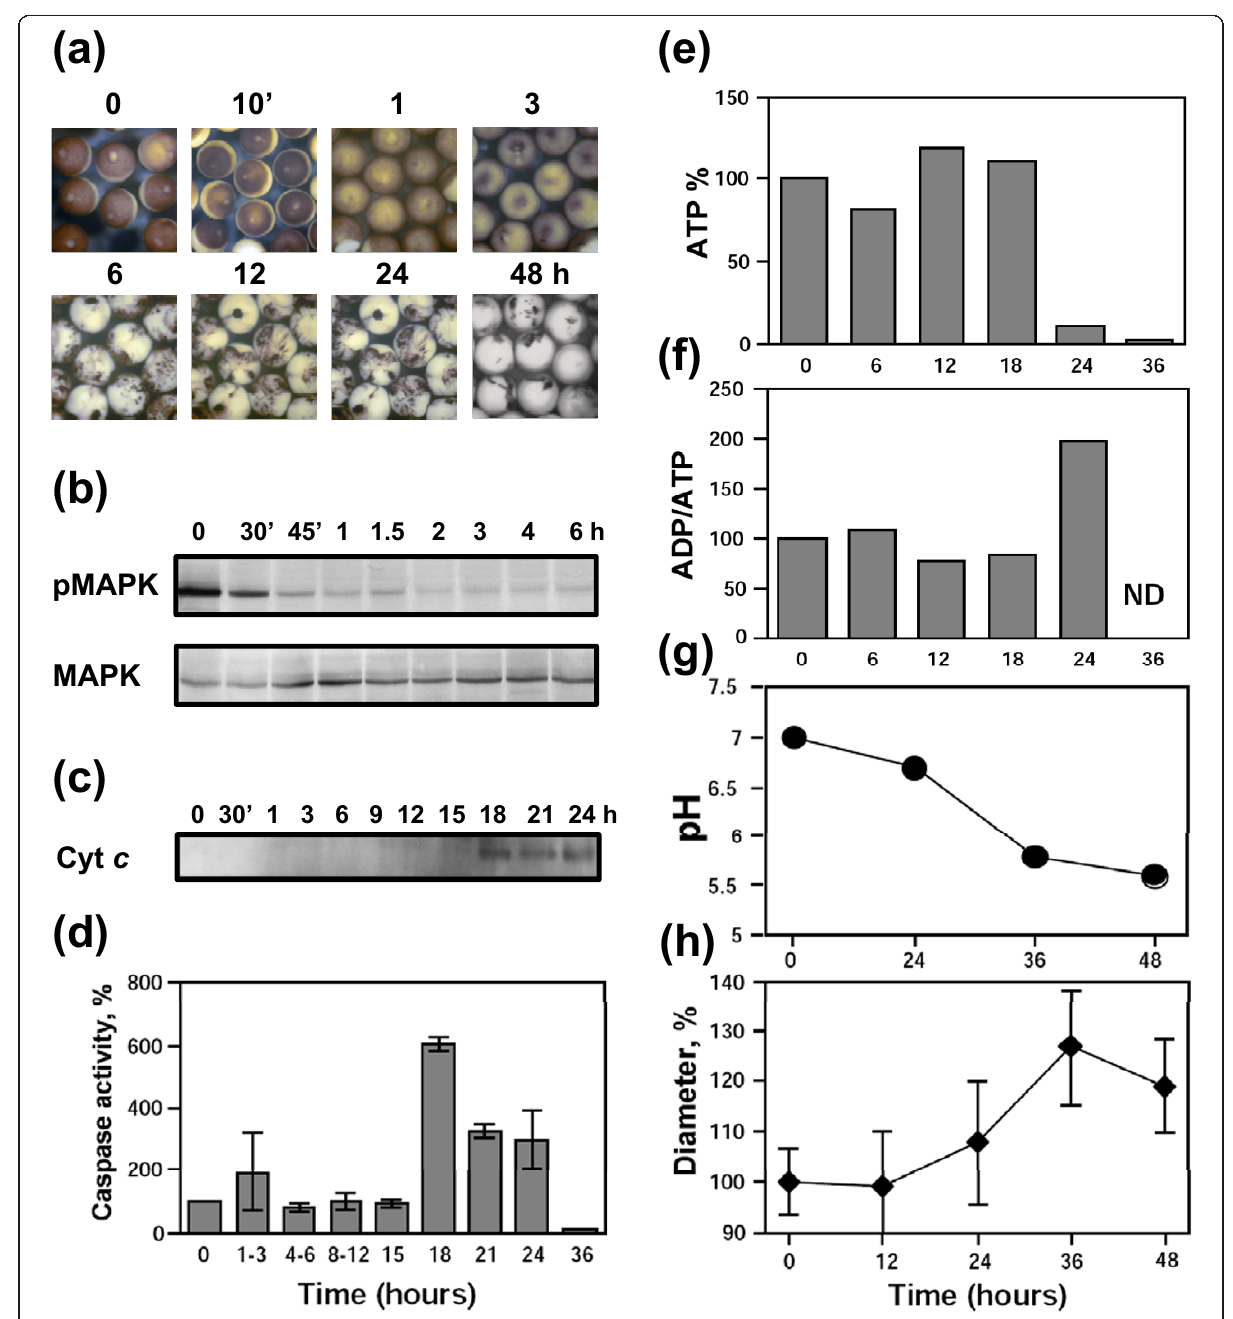
Figure 5 Apoptotic degradation of ionophore-treated Xenopus eggs . Freshly squeezed dejellied eggs were placed into OR-2 buffer, treated with 1 μ M calcium ionophore A23187 for 5 min and monitored over indicated times. Egg morphology (a) , MAPK activation state (b) , cytochrome c release (c) , caspase 3 activity (d) , intracellular ATP content (e) , ADP/ATP ratio (f) , intracellular pH (g) , and egg diameter (h) have been monitored. In panel (d) , the data of three to six measurements in two independent experiments are shown. Bars in panel (h) represent SD of the mean obtained by measurement of three to five